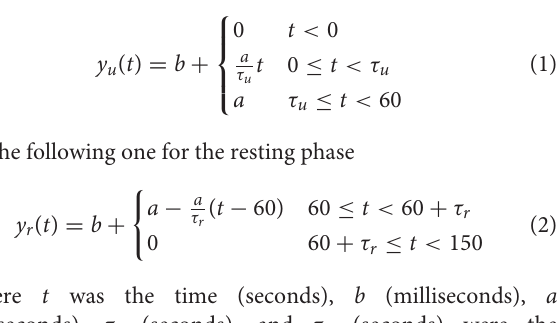
morphological parameters to be estimated. In particular, b